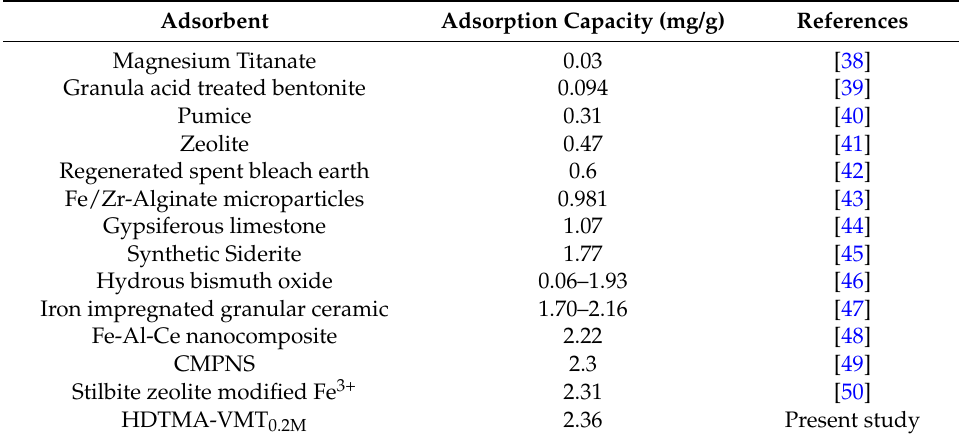
Figure 11. Freundlich plot of HDTMA-VMT 0.2M . Table 2. Fluoride adsorption capacity of various adsorbents in literature.